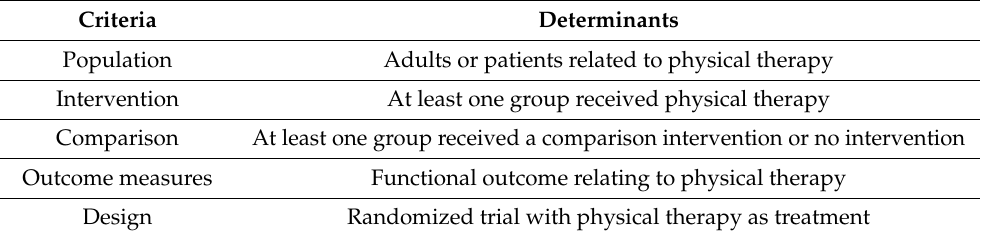
Table 1. Inclusion